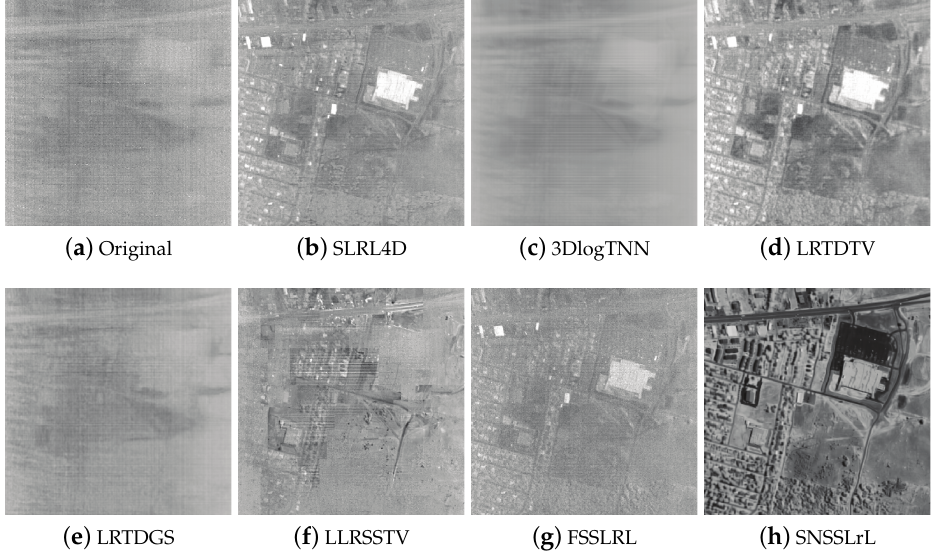
Figure 9. Real comparison of all methods on bands 105 of Urban